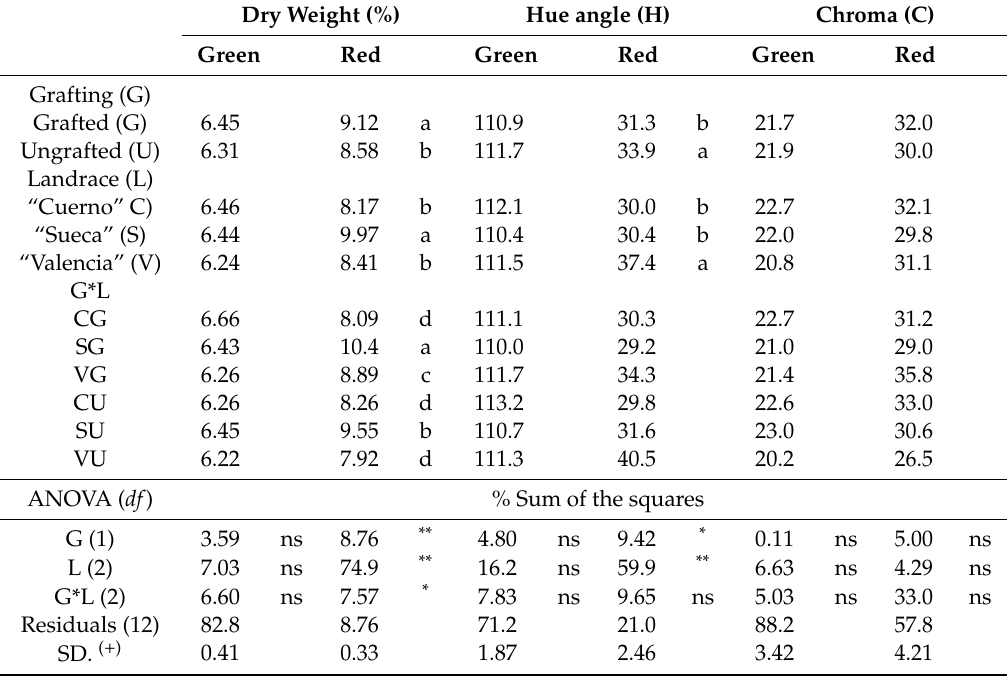
Table 1. Dry weight and color indices in the green and red fruits produced by the three pepper landraces “Cuerno” (C), “Valencia” (V), and “Sueca” (S) grafted (G) or ungrafted (U) on rootstock F1 NIBER ® . Values are the mean of three fruits per replicate (3 replicates) per landrace. Means were subjected to a two-way ANOVA with grafting and landrace as sources of variability. Di ff erent letters for the factors grafting and landrace, or their interaction, indicate significant di ff erences at p < 0.05 using the LSD test. No letter indicates the non-significance of the F ratio. ns: p > 0.05; *: p ≤ 0.05; **: p ≤ 0.01. Dry Weight (%) Hue angle